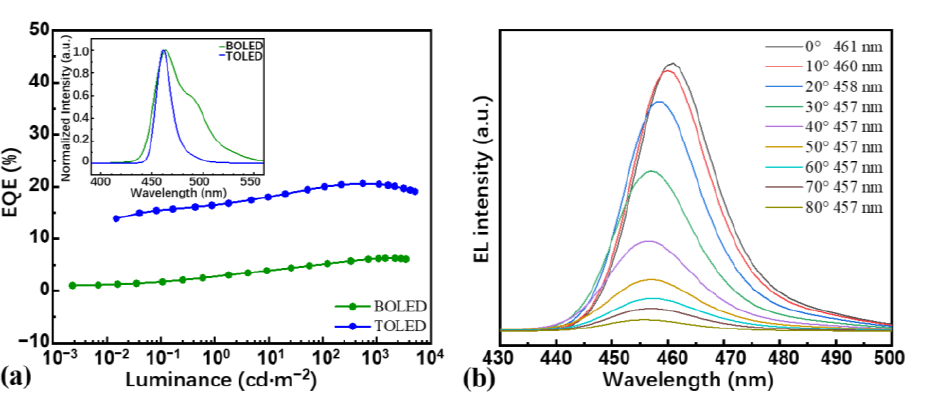
Figure 5. ( a ) EQE-luminance characteristics of the BOLED and TOLED and the EL spectrum as an inset; ( b ) the angular dependence test of the normalized light intensity with the EL emission spectra measured at different angles (0 ◦ –80 ◦ )